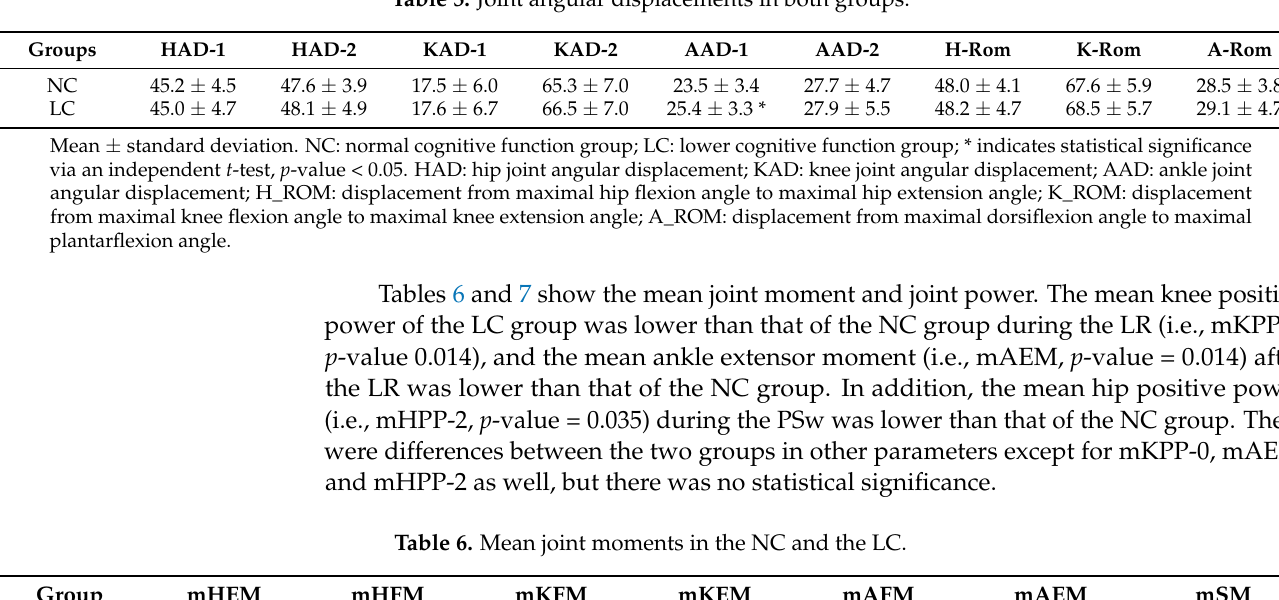
Table 5. Joint angular displacements in both groups.